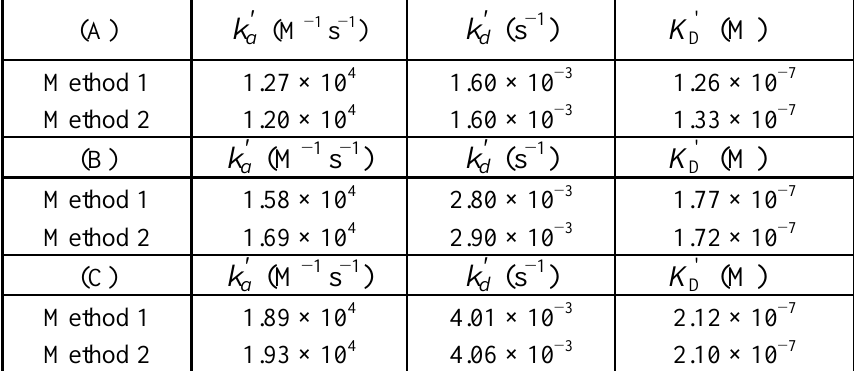
Table 1. Reaction rate constants of the (Human IgG1)-(Anti-Human IgG1) binding reaction in the PBS solution by the basic kinetic analysis for three supplements of Anti-Human IgG1 solution: (A) 800 μL, (B) 500 μL, and (C) 100 μL. Here K '